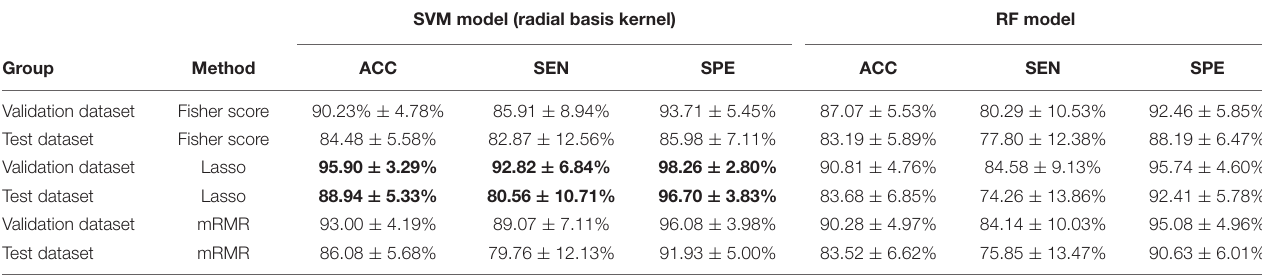
TABLE 3 | Classification performance of the SVM model (radial basis kernel) and RF